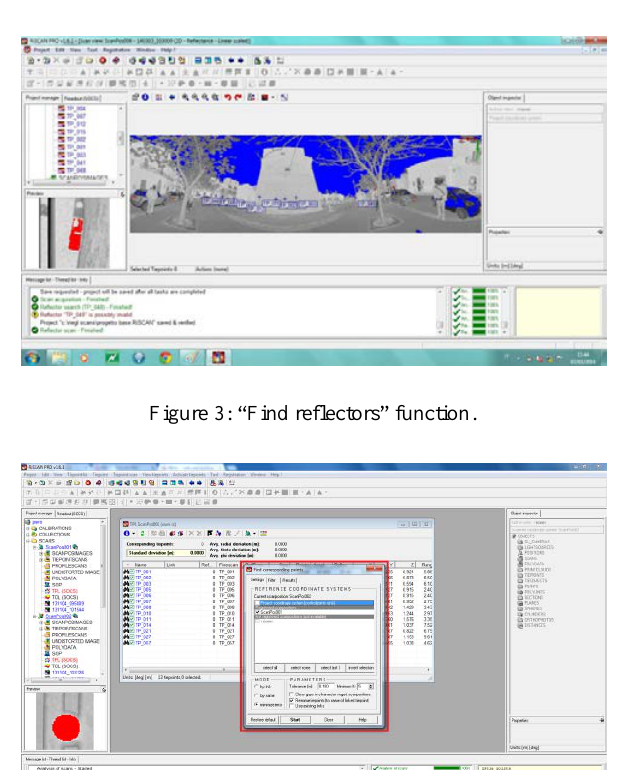
Figure 2: Laser scanner stations (Google maps).